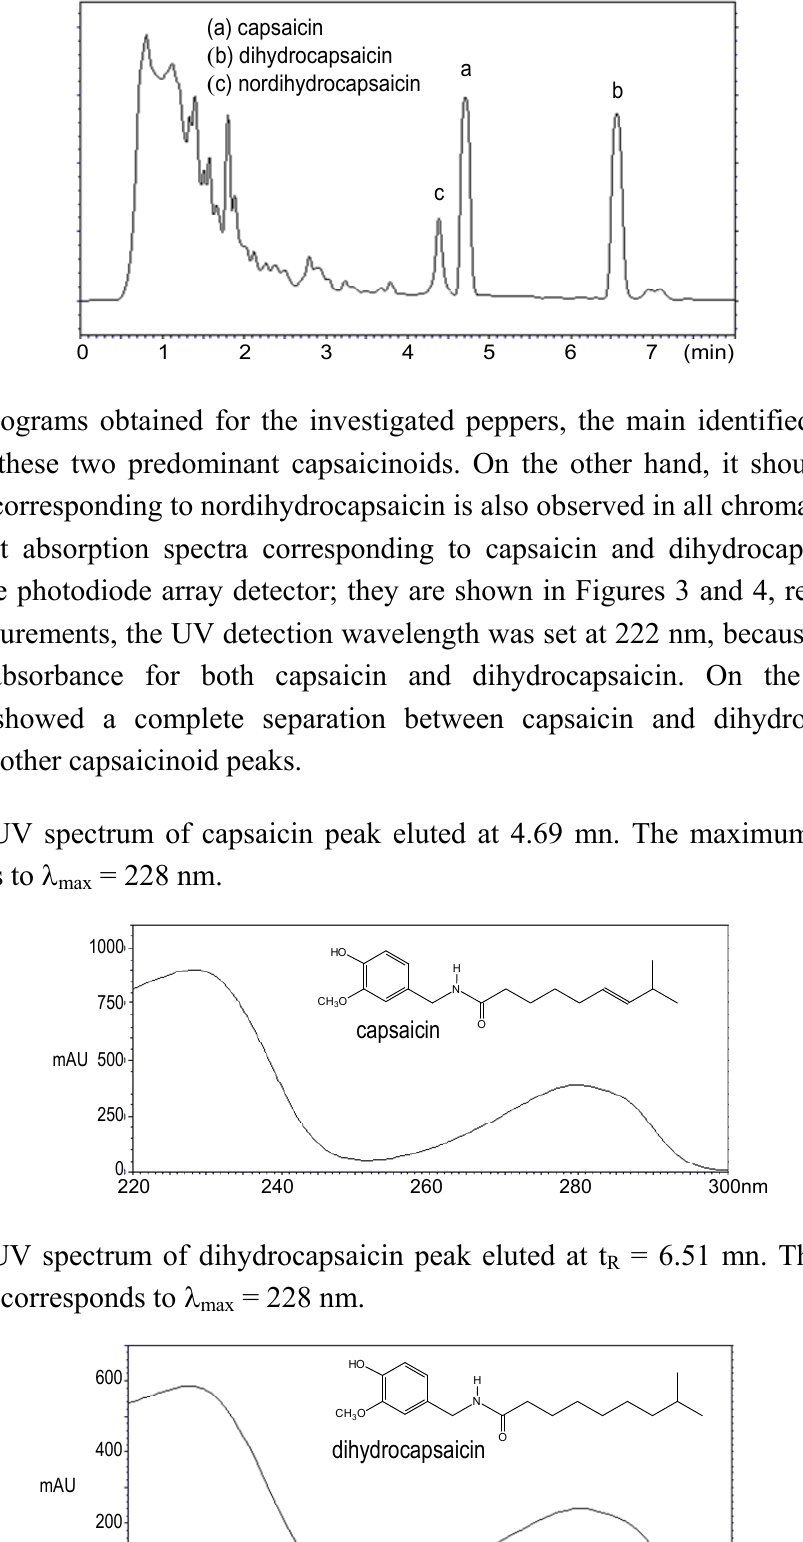
O/CH CN, 50:50 v/v, flow rate: 1.5 mL/min, UV 2 3